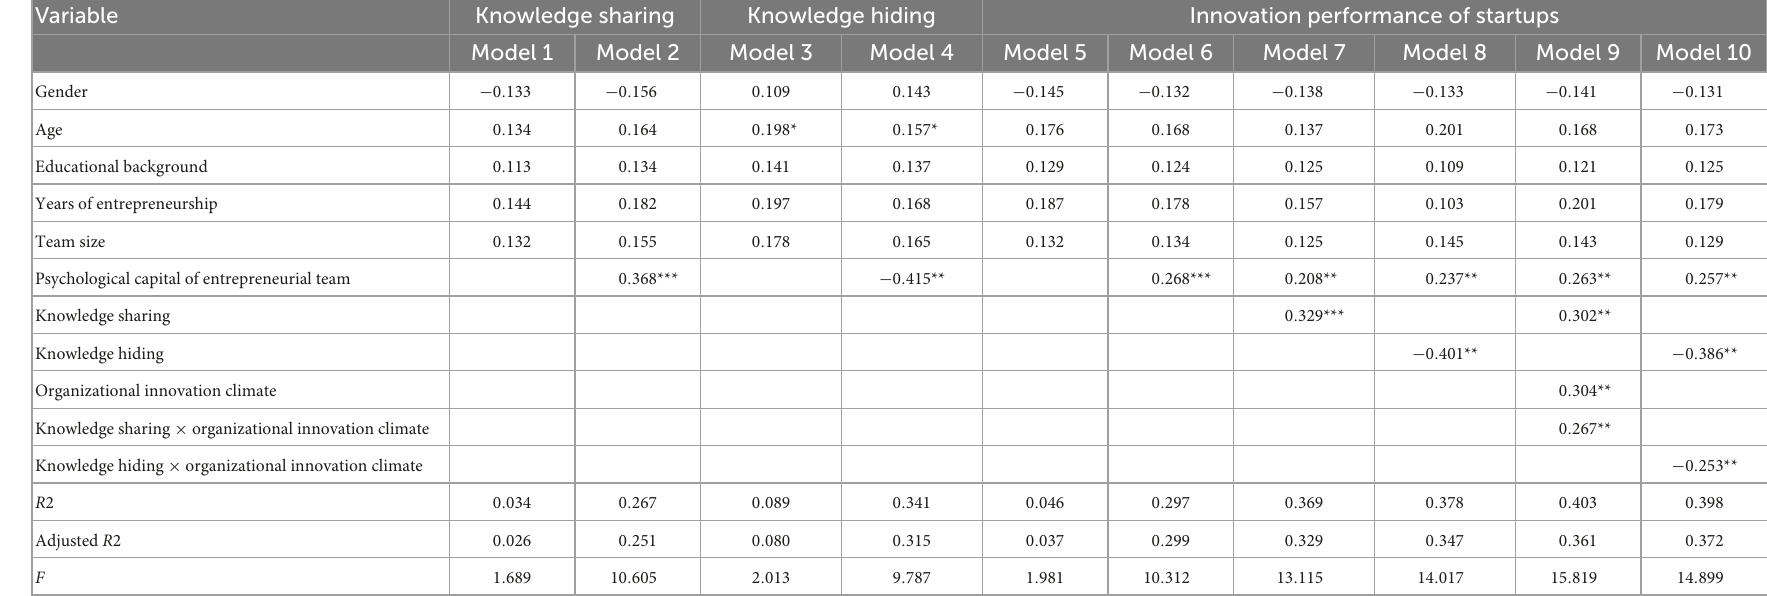
TABLE 4 Sample regression analysis of the impact of entrepreneurial team PsyCap on innovation